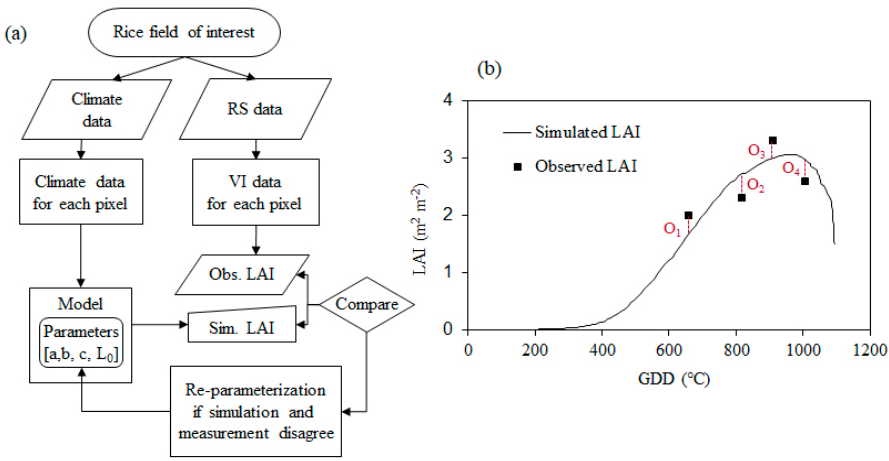
Figure 3. Diagram of the integrated crop modelling system to project spatiotemporal crop productions using the GRAMI model ( a ) and observed (O) and simulated leaf area index (LAI) being matched with a minimal error using the within-season calibration ( b ). GDD = growing degree day; VI = vegetation index.